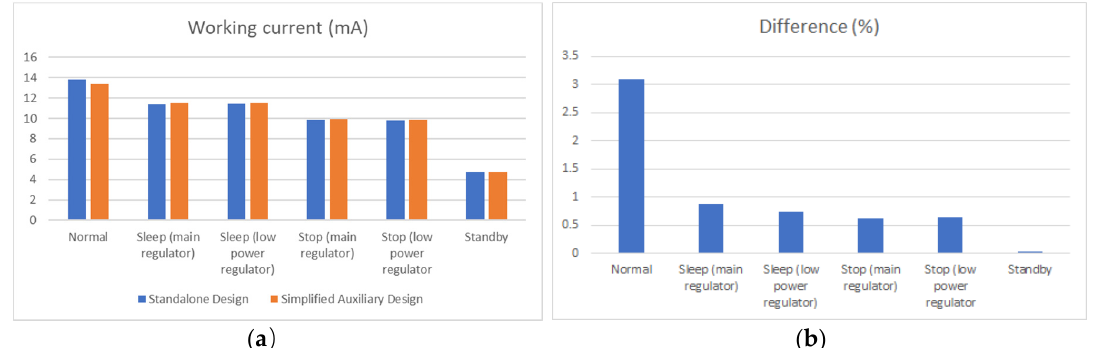
Figure 6. ( a ) Working current of different power modes measured using the standalone design and the simplified auxiliary design. ( b ) Difference (%) between the standalone design and the simplified auxiliary design.